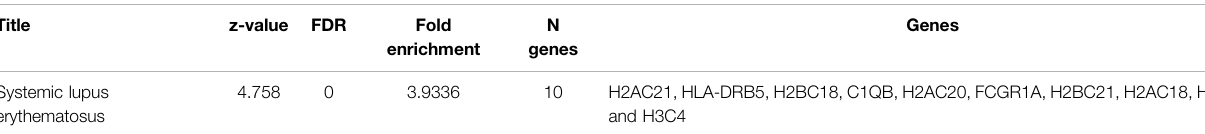
TABLE 8 | Signi fi cantly enriched KEGG pathway of